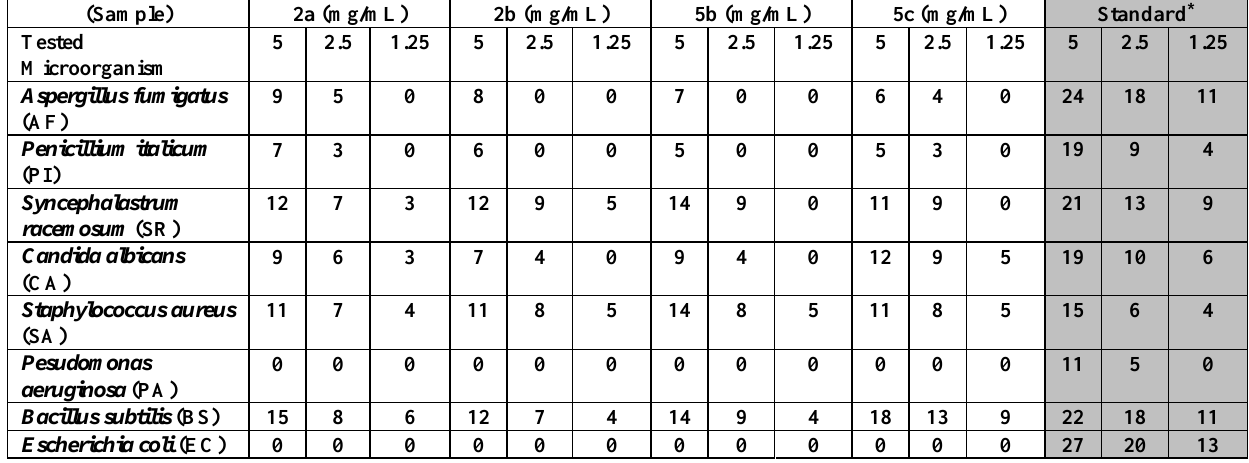
Table 1. Antimicrobial activity of products 2a , 2b , 5b , and 5c .